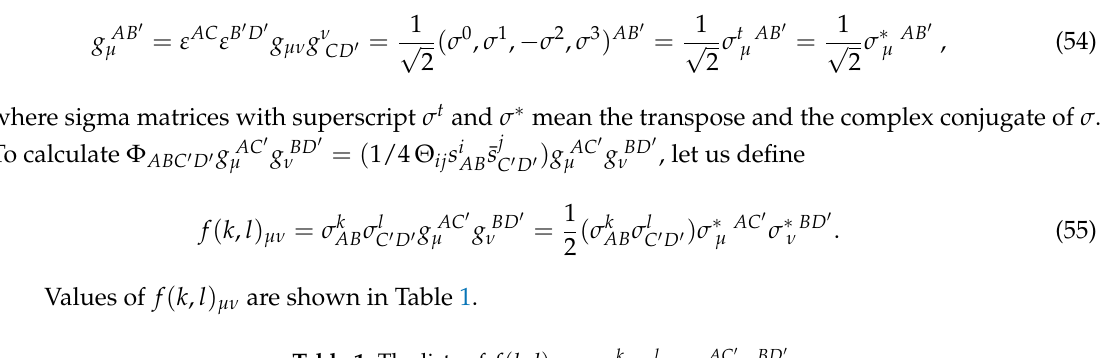
Table 1. The lists of f ( k , l ) µν = σ k